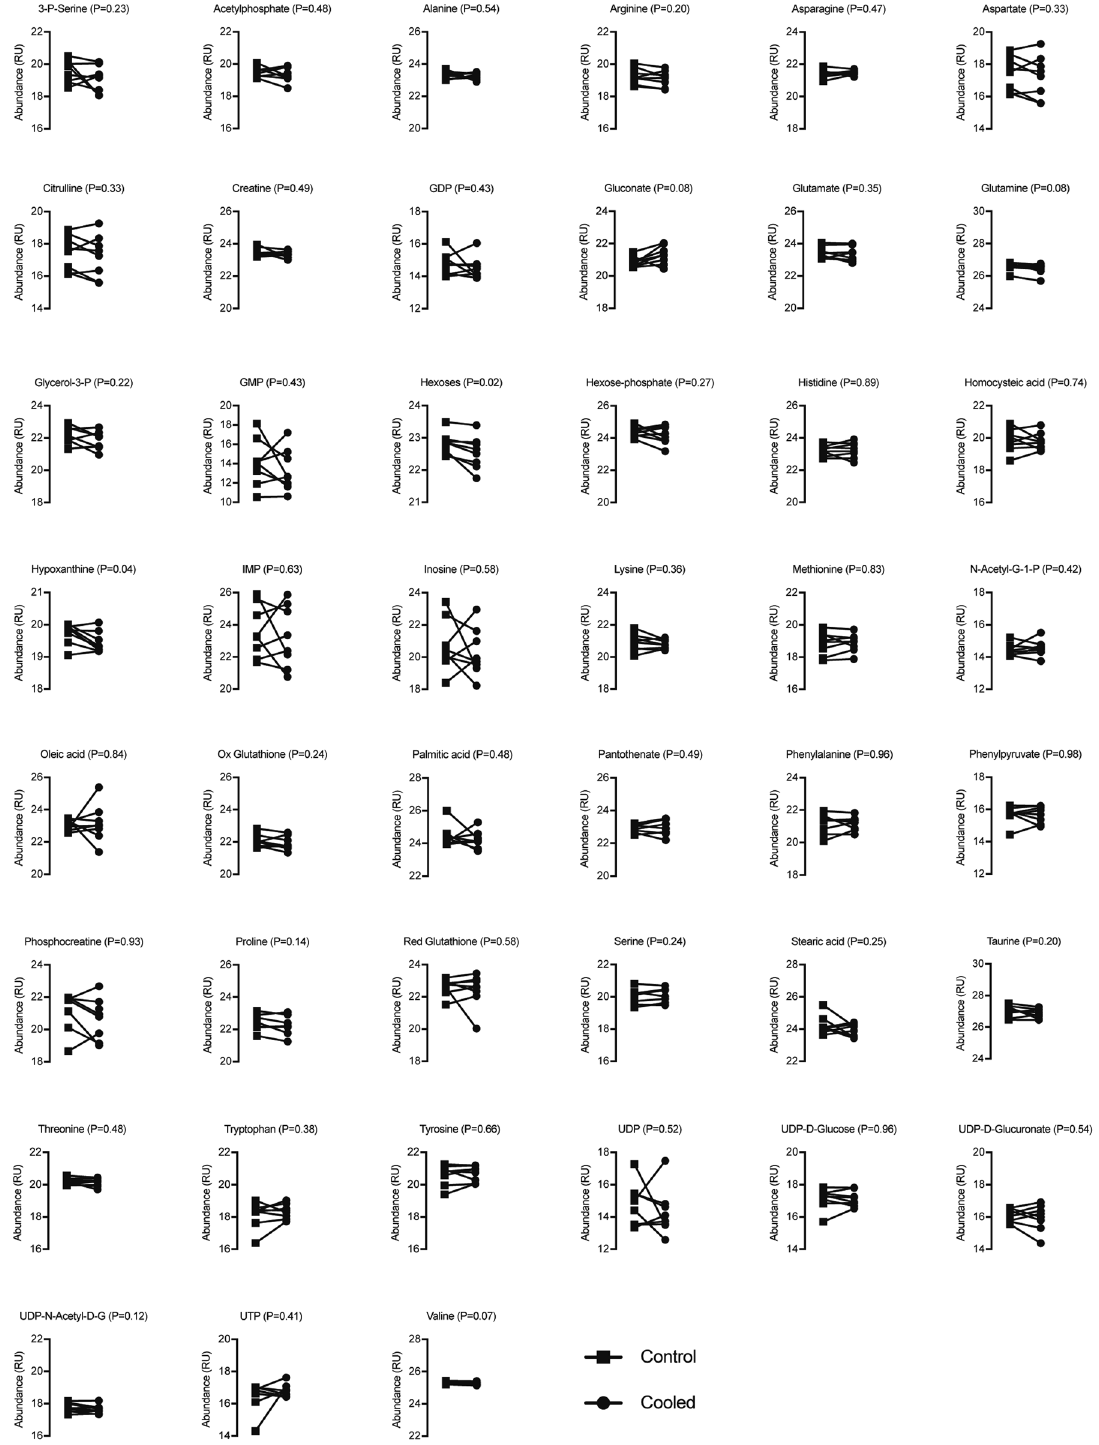
Figure 4. Metabolites without available isotopic standards. Relative abundance of 45 analytes measured in control and cooled muscles. Data were log 2 transformed prior to analysis. Differences were tested using paired t-tests, and p-values are indicated in each panel. Only hexoses and hypoxanthine were significantly different between control and cooled samples. N = 8